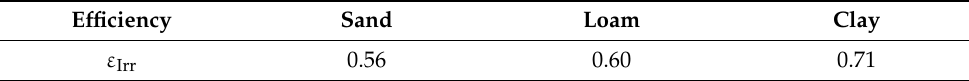
Table 5. Irrigation efficiencies